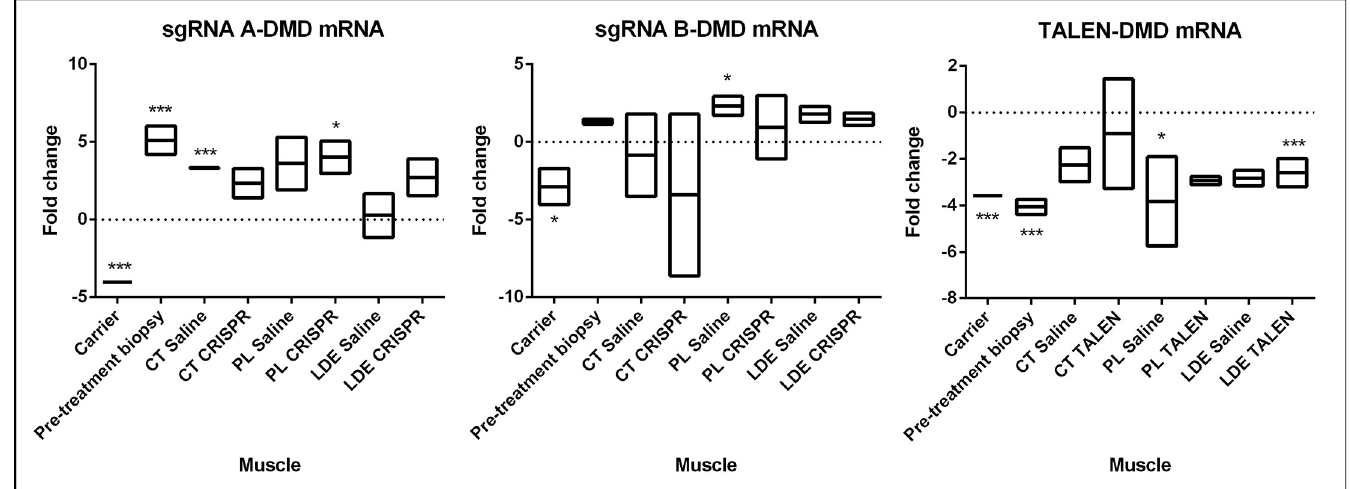
Fig 4. QRT-PCR results analyzed with a pair wise fixed reallocation randomization test. CT values for mRNA area between exon 6–8 of the DMD gene were normalized to HPRT1 (house-keeping gene) as an internal control gene. Samples were analyzed using a pair wise fixed reallocation randomization test, excluding outliers with a Grubb’s test. Vertical boxes include standard error of the mean. RNA was extracted from each muscle and run in triplicate. All values were expressed as fold change compared to the normal dog values, which were also normalized to HPRT1 (dotted line). CT = cranial tibial; PL = peroneus longus; LDE = long digital extensor; � p < 0.05; ��� p <